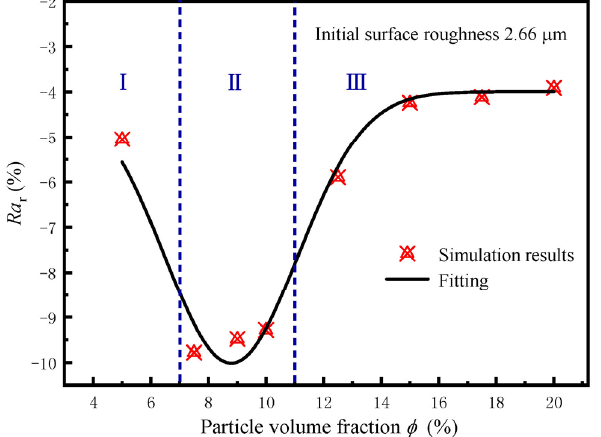
Fig. 6 Magnetic induced relative roughness volume fraction.